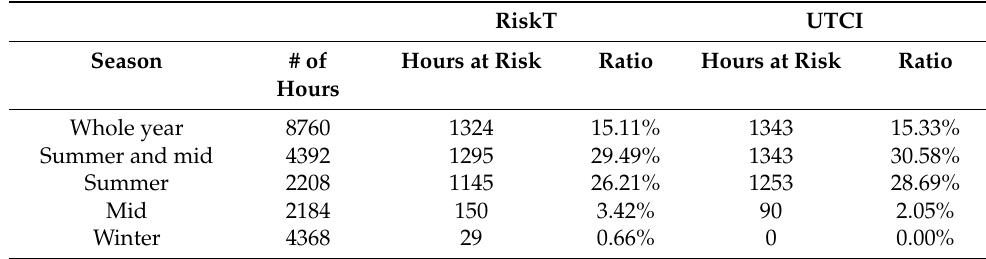
Figure 3. Degree of thermal stress expressed in UTCI , based only on the values for 2019 from Milano v. Juvara of t db − air , RH , and V a . Table 3. Summary results of the allocated thermal stress, when using RiskT > 0.5 or UTCI > 26 as the criterion, differentiated by